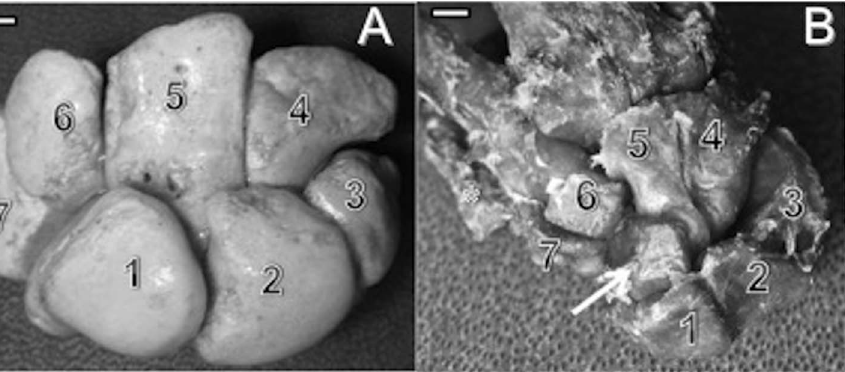
Figure 4. Comparison of human and capuchin carpal bones. A. Carpal bones in the human right hand (top view): (1) scaphoid, (2) lunate, (3) pyramidal, (4) hamate, (5) capitate, (6) trapezoid and (7) trapezium bones (bar=2 cm). B. Carpal bones in the capuchin right hand (top view). The numbers indicate the corresponding bones of figure 14A. The arrow indicate the central bone and the asterisk * indicantes the metacarpal I (bar=6 cm). The pisiform bone is not visible in either photographs.